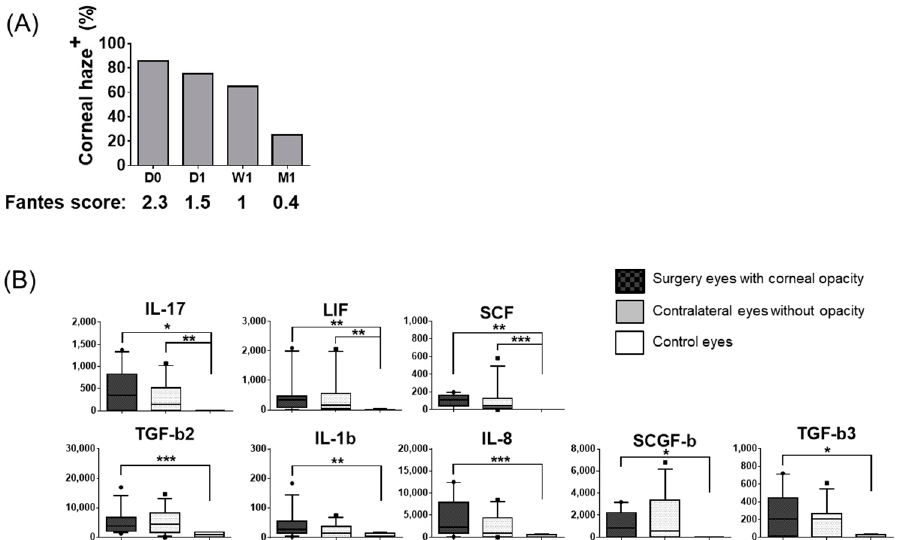
Figure 5. Tear fluid cytokines increased in bilateral eyes with unilateral corneal haze. ( A ) Frequencies and average scores of corneal haze in the transplant eyes at each time point are shown. n = 21. ( B ) Baseline protein expression levels were compared between transplant eyes with corneal haze, non-transplant eyes without corneal haze, and age-matched controls. Patients receiving corticosteroid treatment before surgery were excluded. Corneal haze + transplant eyes: n = 11, corneal haze - non-transplant eyes: n = 11, age-matched controls: n = 4. The median, 10%, 25%, 75%, 90% percentiles are shown. pg/mL. * p < 0.05, ** p < 0.02, *** p < 0.01.